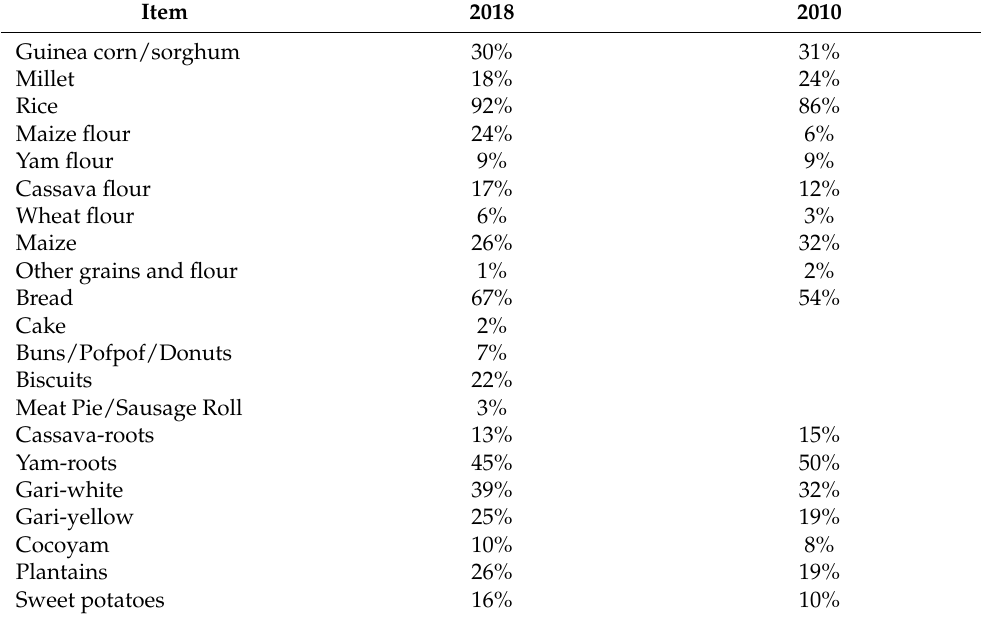
Table A4. Foods consumed in the 7 days prior to the survey by Nigerian households in 2010 and 2018